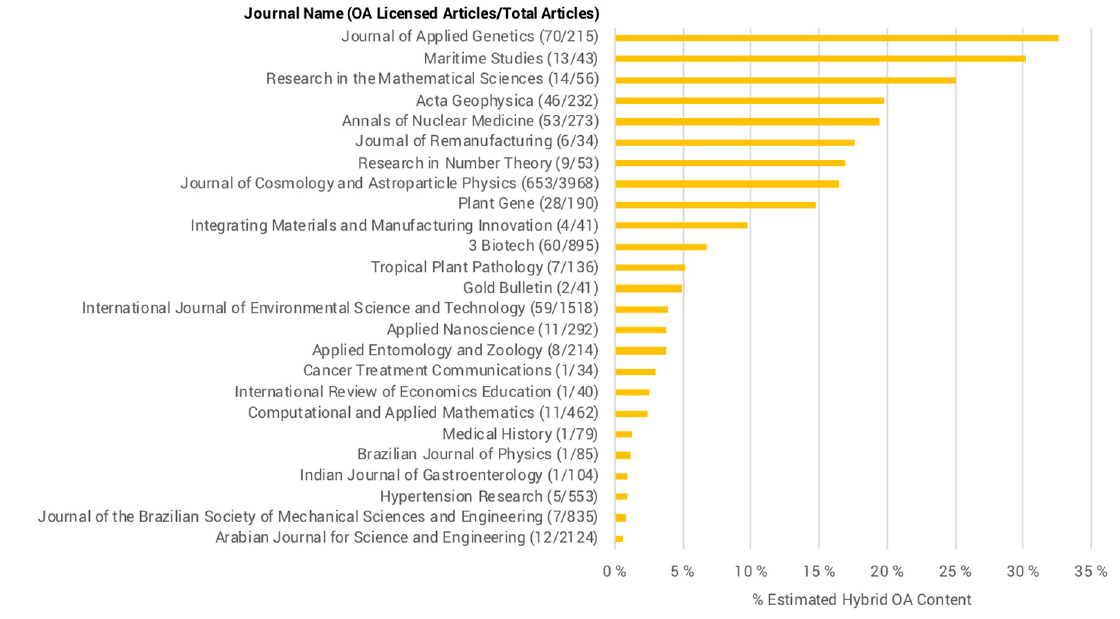
Figure 14. Estimated shares of hybrid OA in 25 reverse-flip journals.